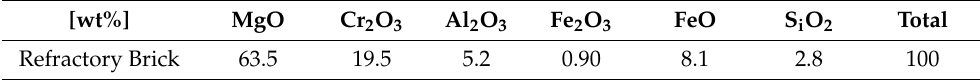
Table 3. Composition of the selected refractory brick according to the supplier datasheets.